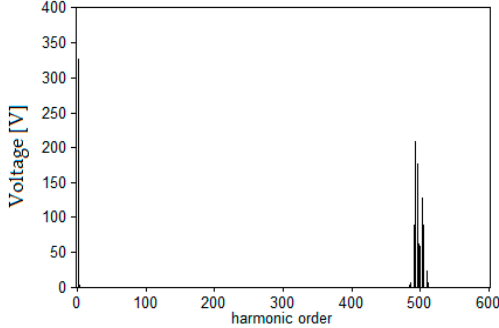
Figure 11. Fourier analysis of the load voltage, synthesized in the MC controlled by the use of the CCW rotating space vectors, for three ‐ phase open ‐ end load and output frequency of 30 Hz.